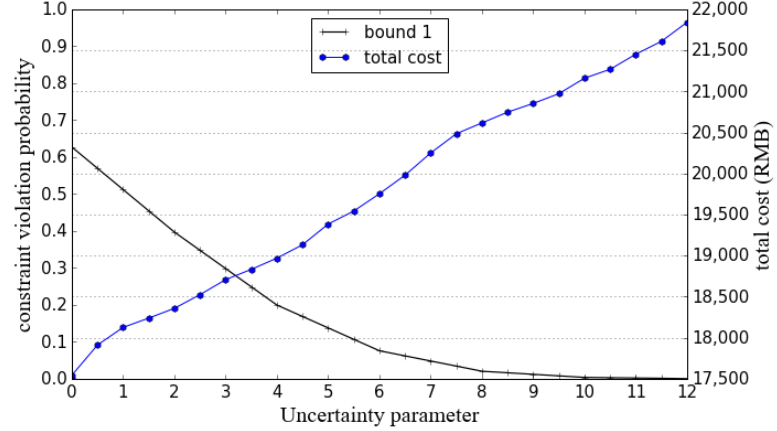
Figure 8. The relationship between operating cost and constraint violation probability.